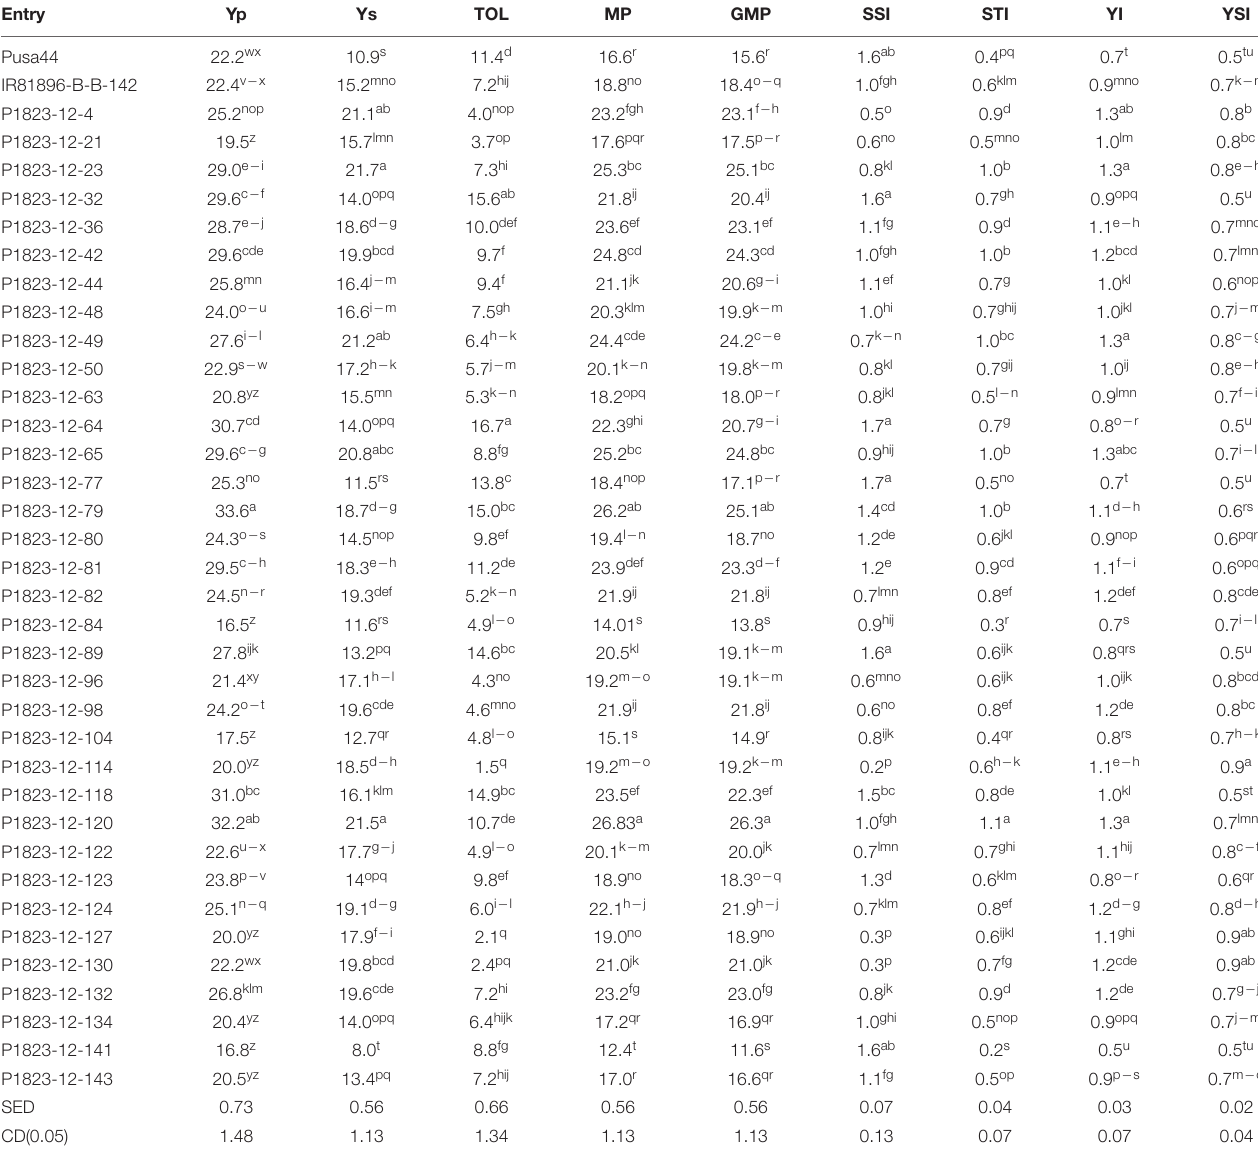
TABLE 4 | Drought indices and yield performance of Pusa 44 qDTY NILs in field